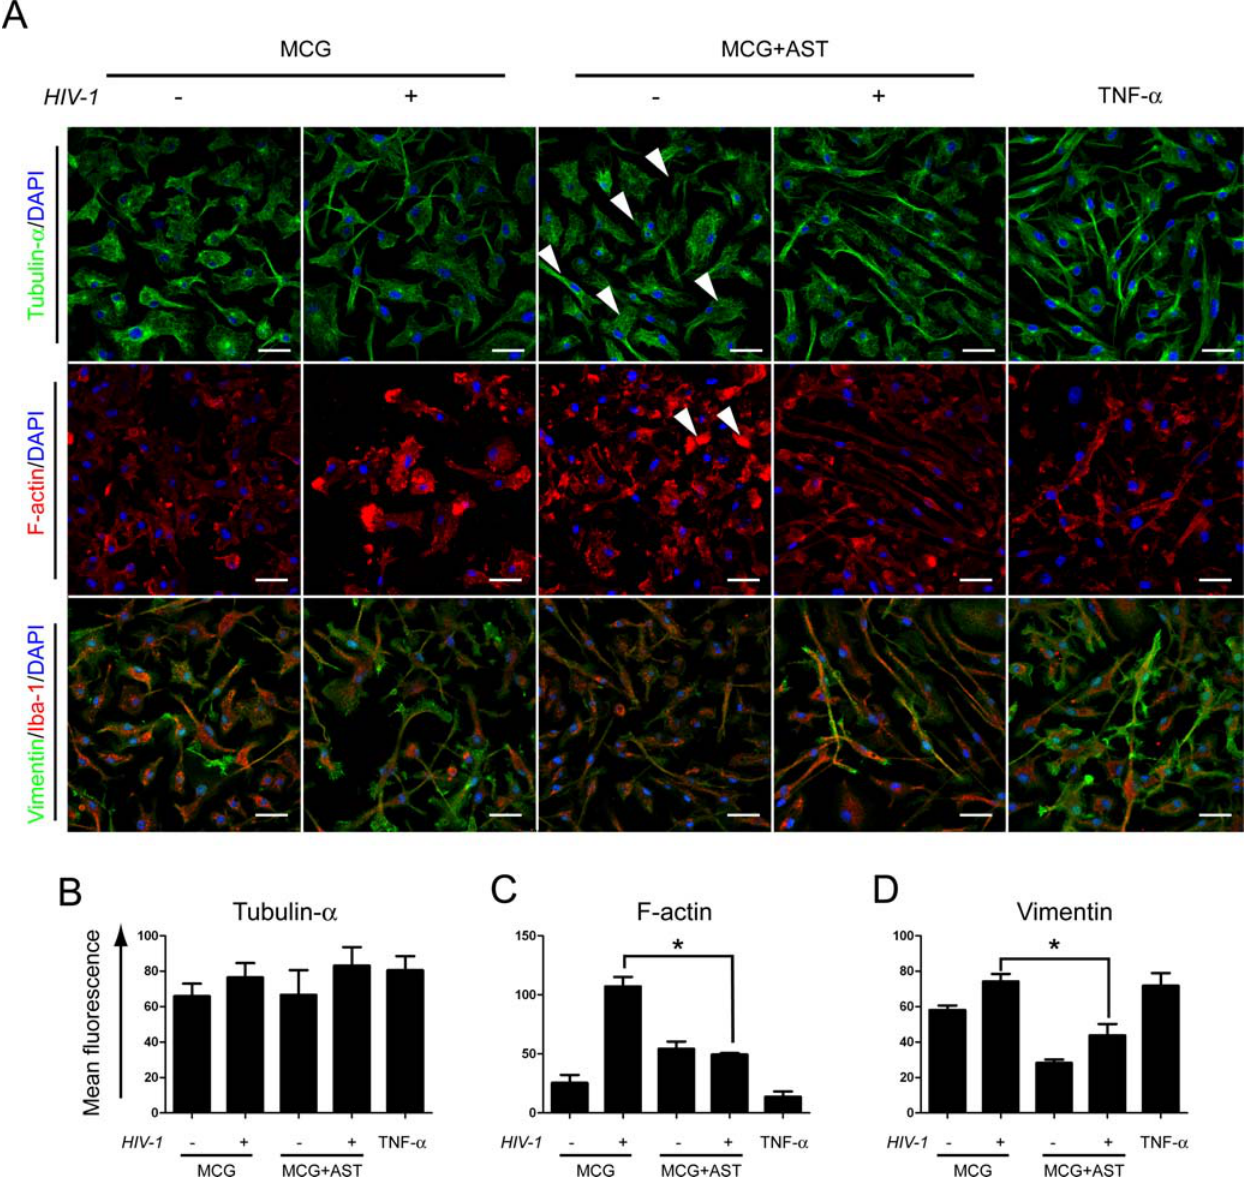
Figure 4. Immunohistochemical validation of proteomic profiling. Uninfected or HIV-1/VSV infected microglia were cultured for 24 h in the absence (MCG) or presence of astrocytes (MCG + AST). This arbitrary time point was chosen as it reflected dynamic changes in cell-cell interactions. Uninfected microglia cultured in the presence of 20 m g/ml TNF- a for 6 hours served as an activated microglia control. (A) Microglia were stained for the expression of the cytoskeletal proteins tubulin- a (green) and F-actin (red); the specific microglial marker ionized calcium binding adaptor molecule 1 (Iba-1) (red); and the activation indicator, vimentin (green). DAPI staining of nuclei shows total number of microglia. Arrowheads point to migratory morphologies. Scale bar, 20 m m; original magnification, 6 63. Quantification of (A) tubulin- a , (B) F-actin, and (C) vimentin expression was performed via laser confocal microscopy and the ratio of overall fluorescence to cell numbers was calculated by digital image analysis using Image- Pro Plus version 5.1 software (Media Cybernetics, Inc.). Significant differences in mean fluorescence 6 SEM for n=5 determinations/group was performed by one-way ANOVA and Tukey’s post-hoc multiple comparisons where p , 0.05 was considered significant.